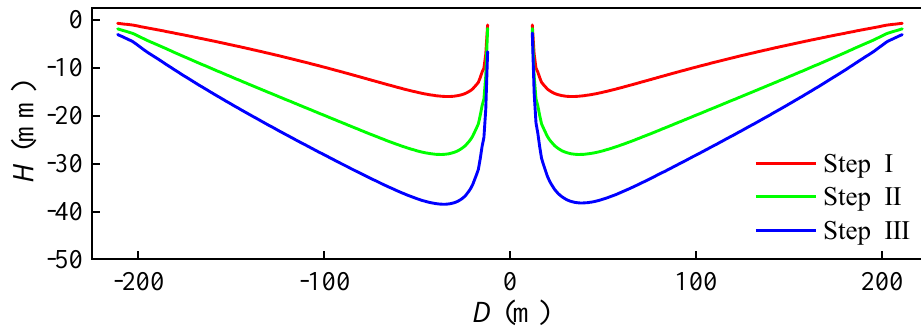
Figure 7. Surface settlement curves outside the excavation for different construction stages.